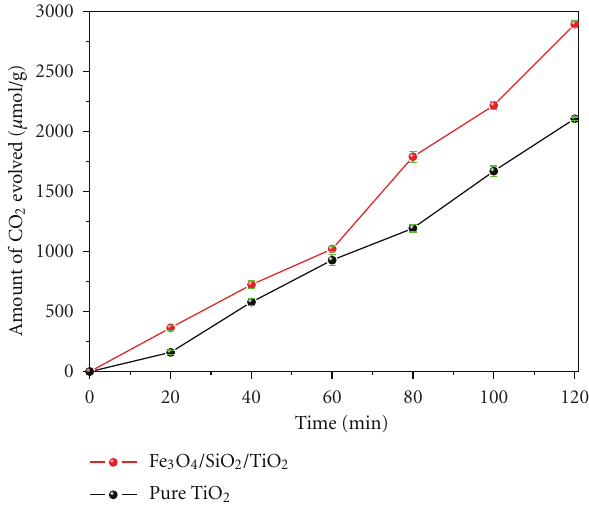
Figure 8: Relationship between the amount of CO 2 evolved and irradiation time for photocatalytic degradation of acetic acid aqueous